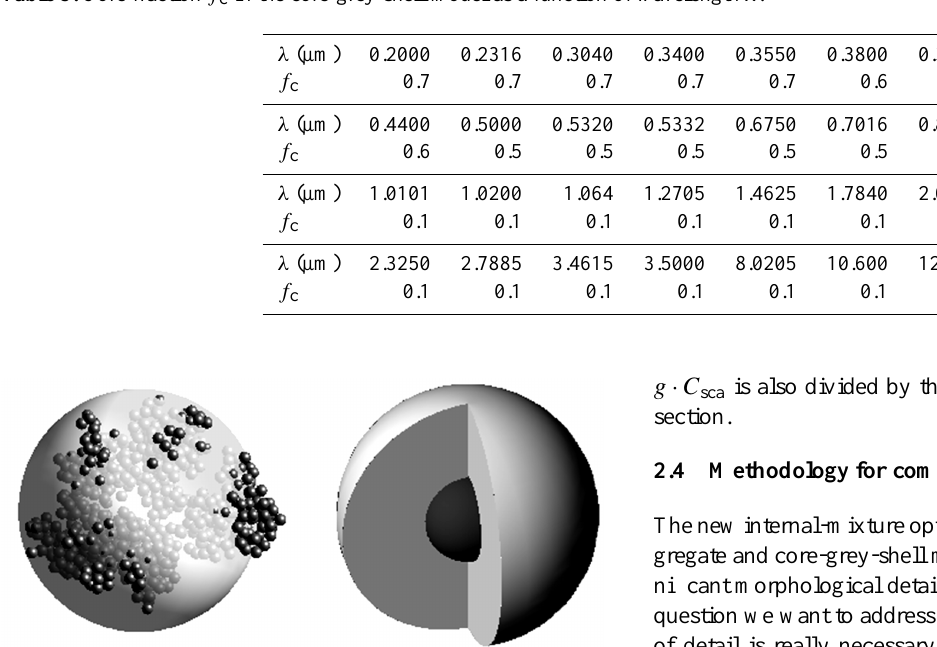
Table 3. Core fraction f c in the core-grey-shell model as a function of wavelength λ .